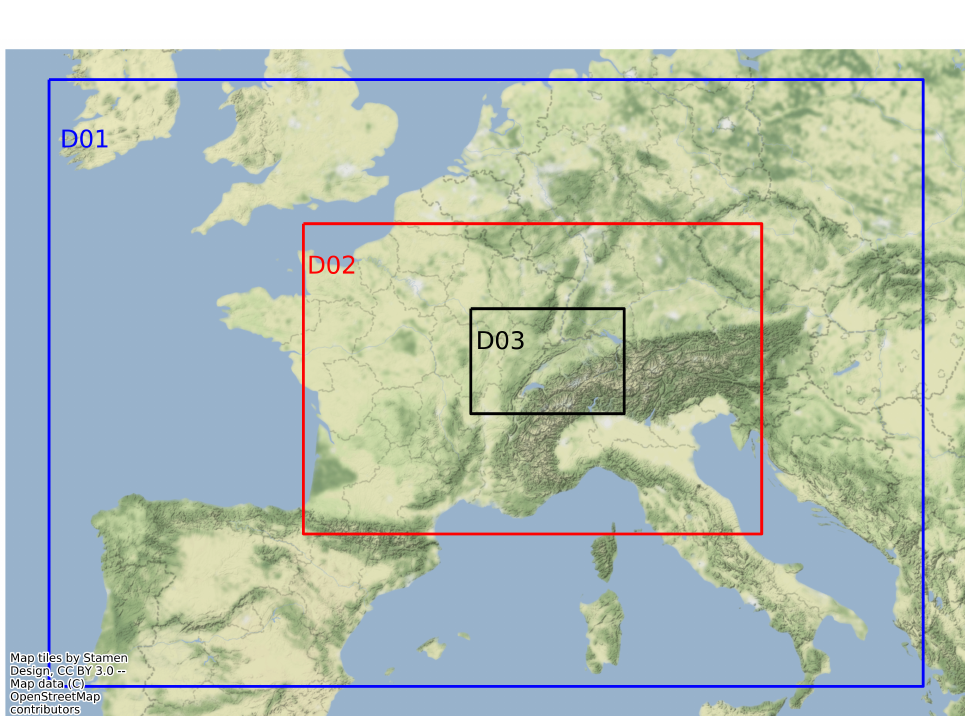
Figure 3. An illustration of the three nested domains (DO1,DO2,DO3) used by WRF to run the meso-scale meteorological model. The Juvent wind farm is located at the center of the third domain on the crest of the Jura mountains in